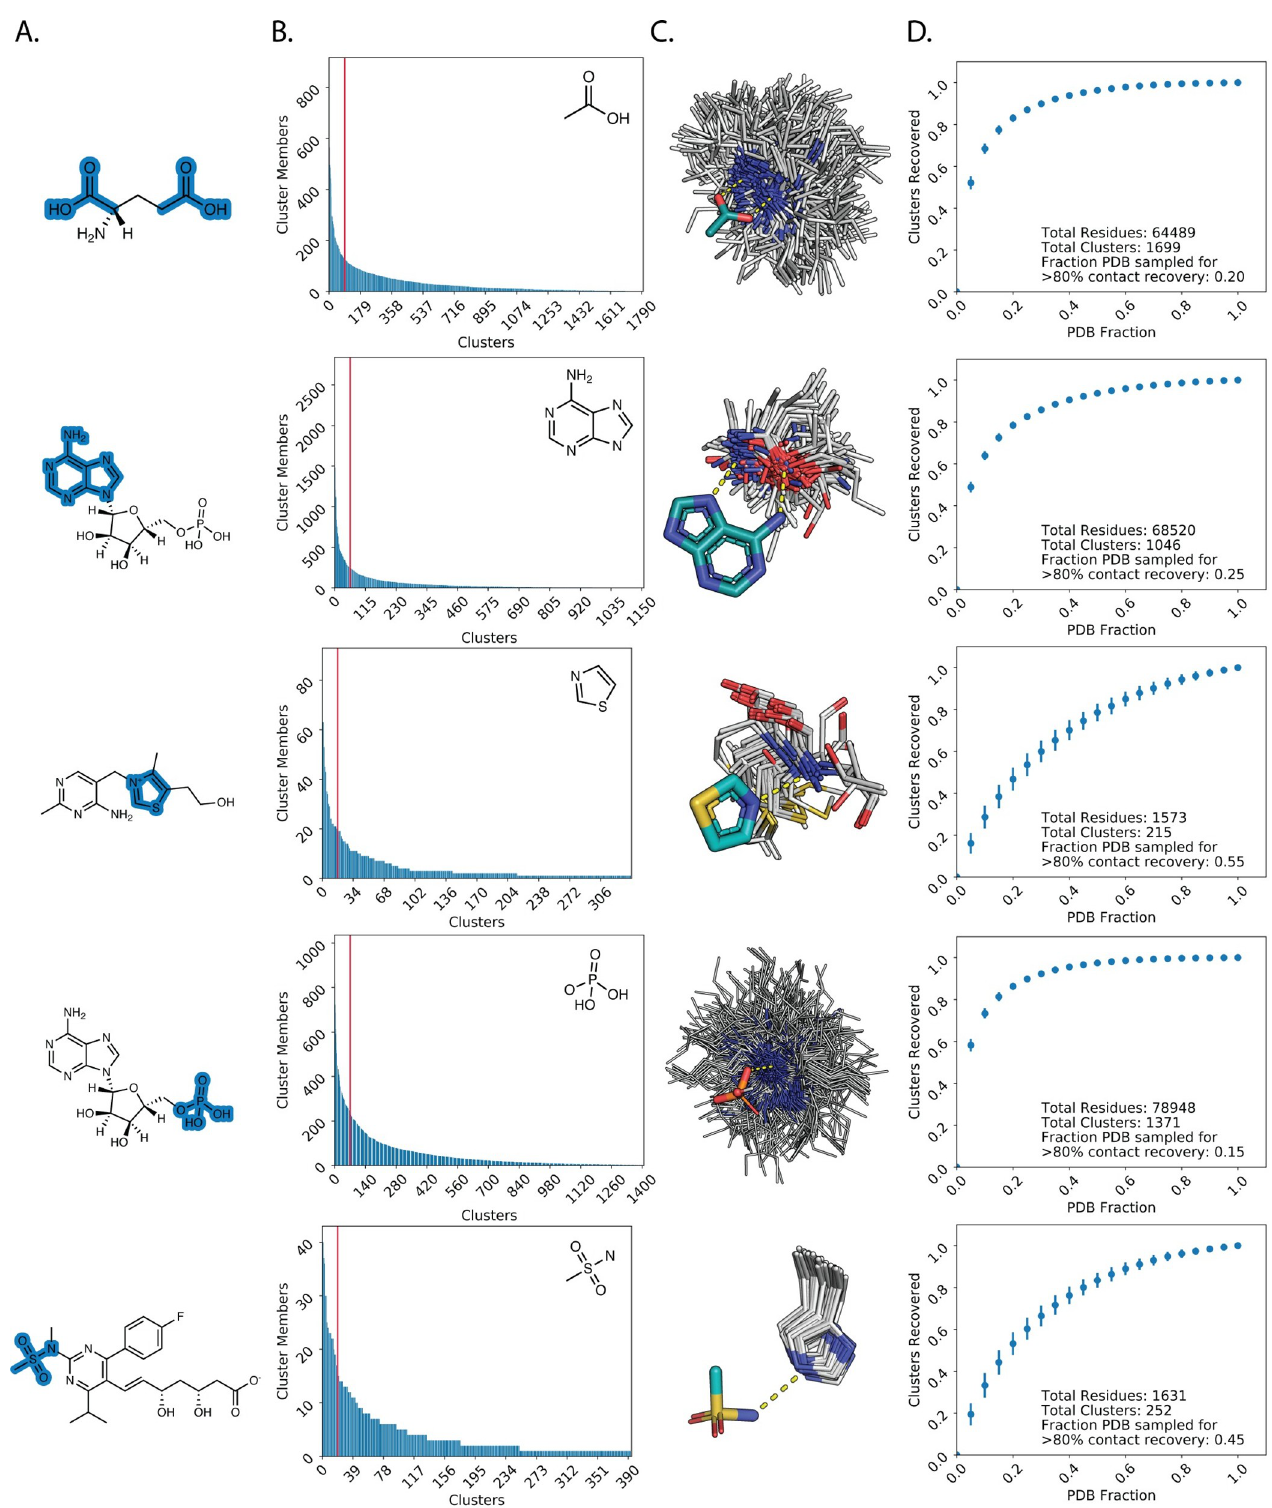
Fig 2. PDB sufficiently samples ligand-fragment contact space. A. Examples of fragment definitions (highlighted in blue) and context as a substructure of a small molecule. B. Clusters for each fragment are plotted in order of the number of members for each cluster (“contact mode”). Clusters to the left of the red vertical line represent the top 5% (high-occupancy) contact modes. C. Examples of high-occupancy clusters for fragments that illustrate expected favorable